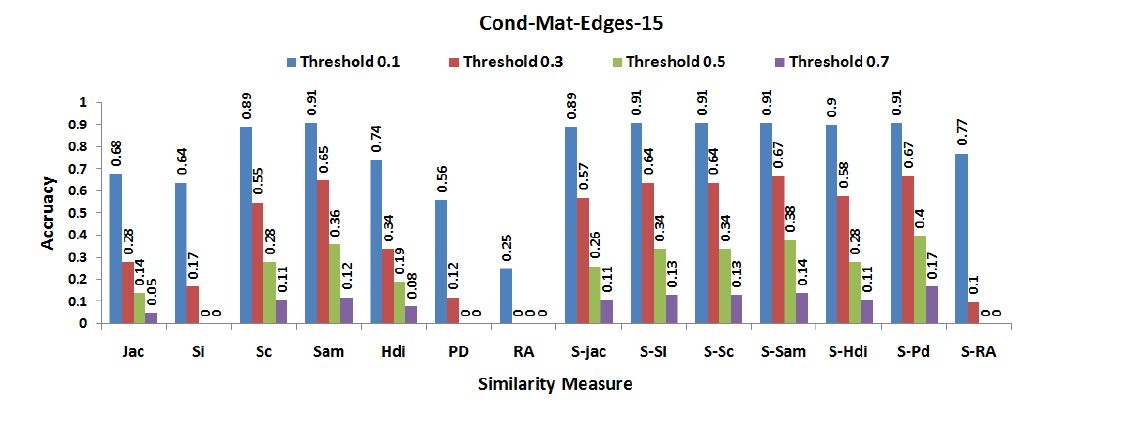
Figure 7. Prediction Results using CondMat Dataset with 15%